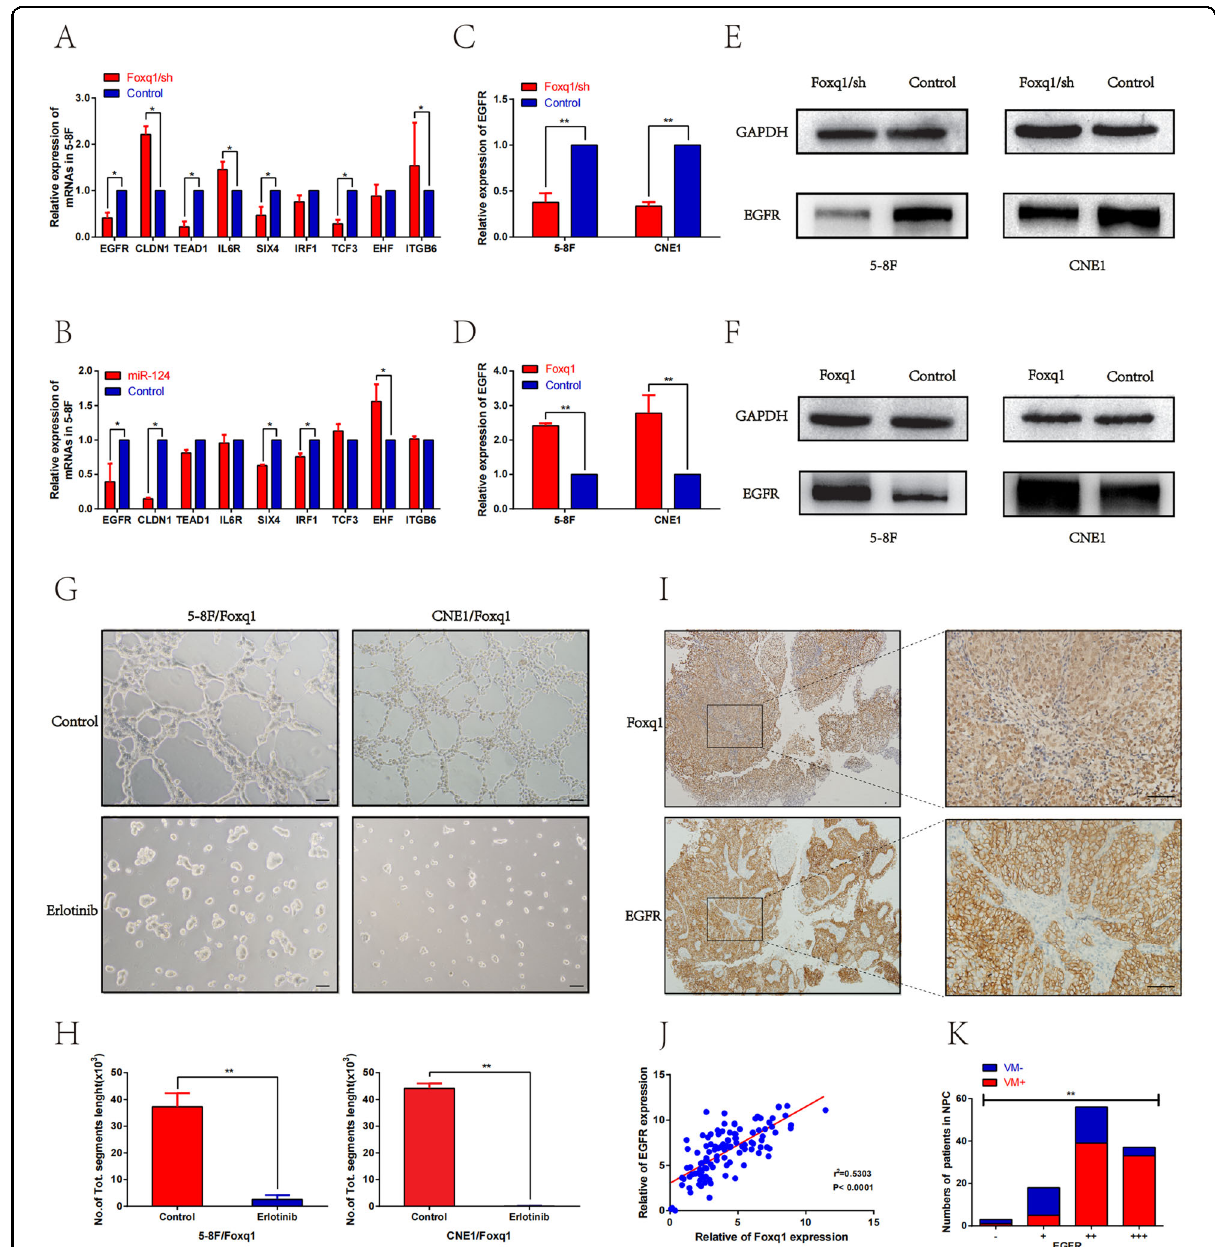
Fig. 3 Foxq1 increases the expression of EGFR, while Erlotinib inhibits Foxq1-induced VM formation. A , B qRT-PCR was used to assess the expression of predicted genes in 5 – 8F cells that overexpressed miR-124 or had a Foxq1 knockdown. C – F qRT-PCR (left) and western blot (right) of EGFR expression in Foxq1 dysregulated 5 – 8F, and CNE1. G VM channel formation in 3D culture of cells overexpressing Foxq1 after treatment with Erlotinib (20 μ M) or DMSO. H The statistical results of the average numbers of tubular structures in each group; p < 0.001. I Region showing typical expression of Foxq1 and EGFR in NPC tissues; Scale bars represent 50 μ m. J Pearson correlation analysis of the association between Foxq1 and EGFR in NPC tissues ( r ² = 0.5303; p < 0.001). K Relationship between the grades of EGFR and VM in NPC tissues; p < 0.001. Data are presented as mean ± SD of three independent